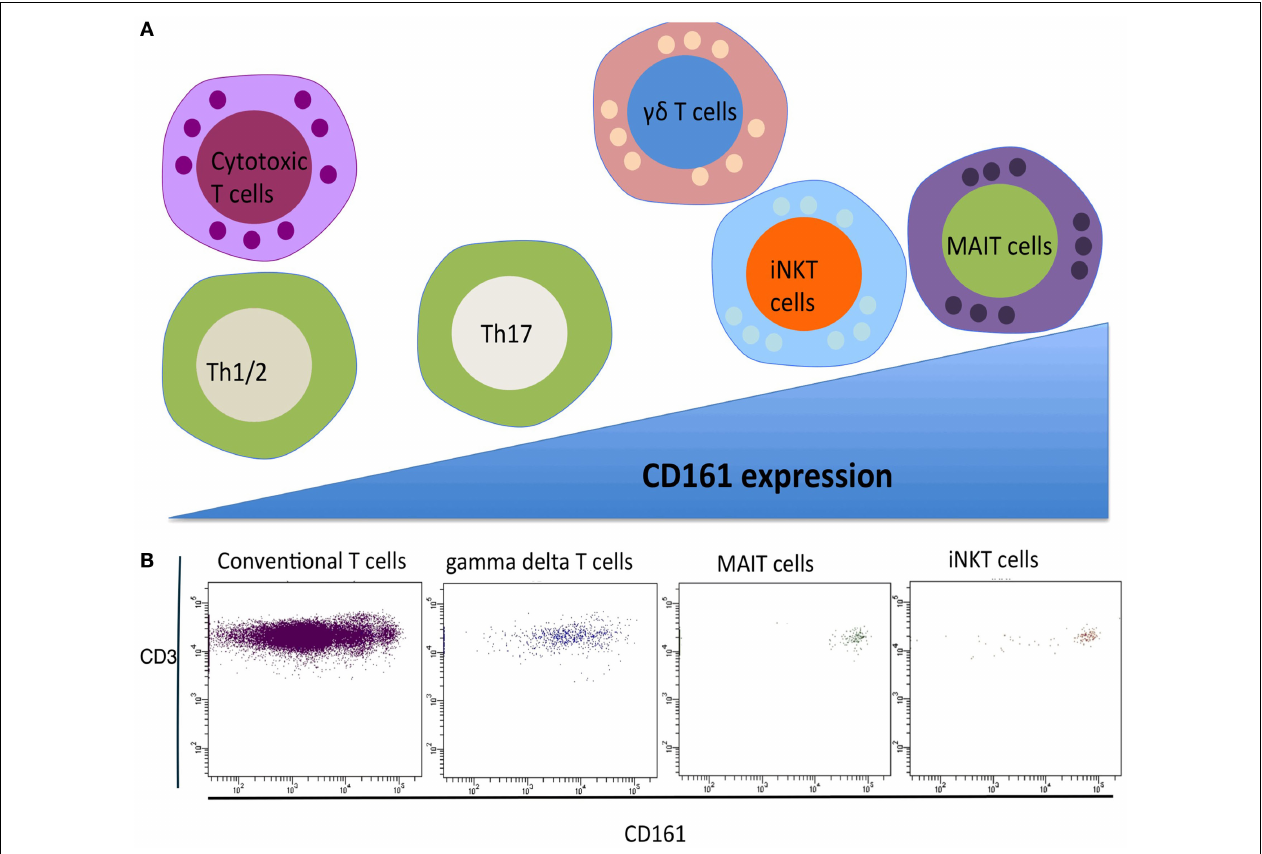
FIGURE 1 | (A) CD161 expression of T cell subsets. Gamma delta T cells, iNKT cells, and MAIT cells express CD161 at a higher level compared to conventional T helper and T cytotoxic T cells. (B) FACS analysis of CD161 expressing in different human T cell